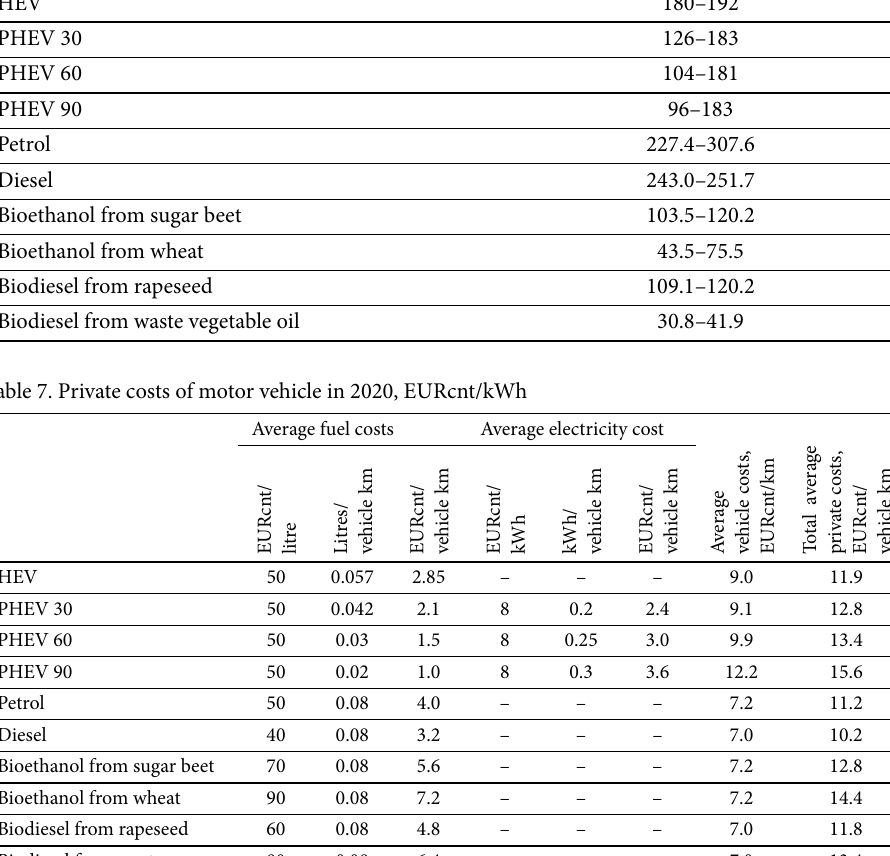
Table 6. Life cycle GHG emissions of road transport technologies Life cycle GHG emissions of the momotor vehicles in g/vehicle